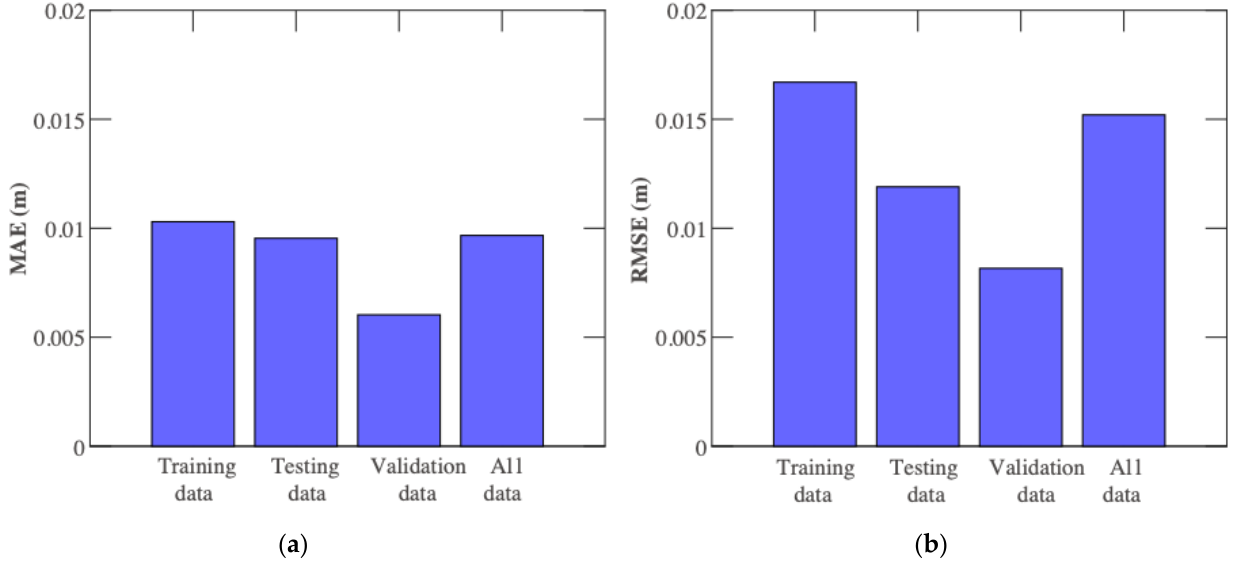
Figure 14. Activation functions of ANN model: ( a ) MAE ( b ) and RMSE.